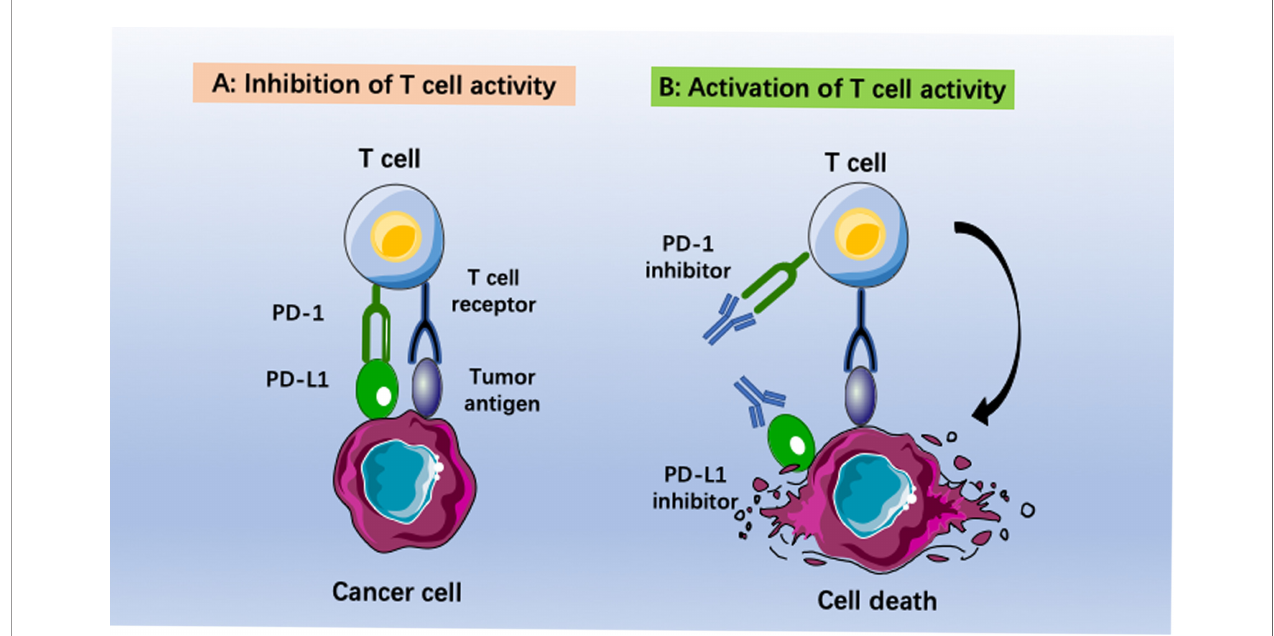
FIGURE 1 | Immunotherapies based on anti-PD-1/PD-L1 pathway antibodies. (A) Inhibition of T cell activity caused by binding programmed death ligand 1 (PD-L1) to programmed death (PD-1). (B) Activization of T cell activity by using anti-PD-1 or anti-PD-L1 antibodies. The cancer cells become immunogenic again. This leads to recognition of tumor cells by T cells and fi nal elimination by the host immune